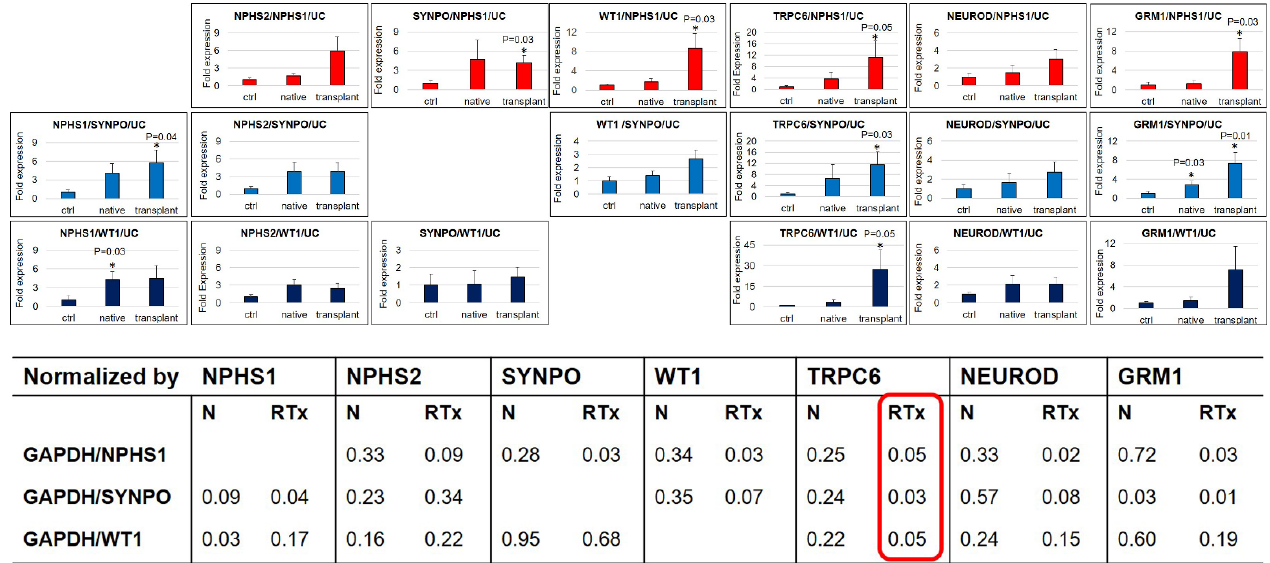
Figure 5. RTqPCR normalization for podocyte number. The fold expression of genes normalized with GAPDH was further normalized using the expression of, respectively, NPHS1 , SYNPO , and WT1 , followed by UC correction. Significance * p < 0.05. p -values (lower figure) obtained by comparison with the CTRL are calculated with two-tailed unpaired t -test.